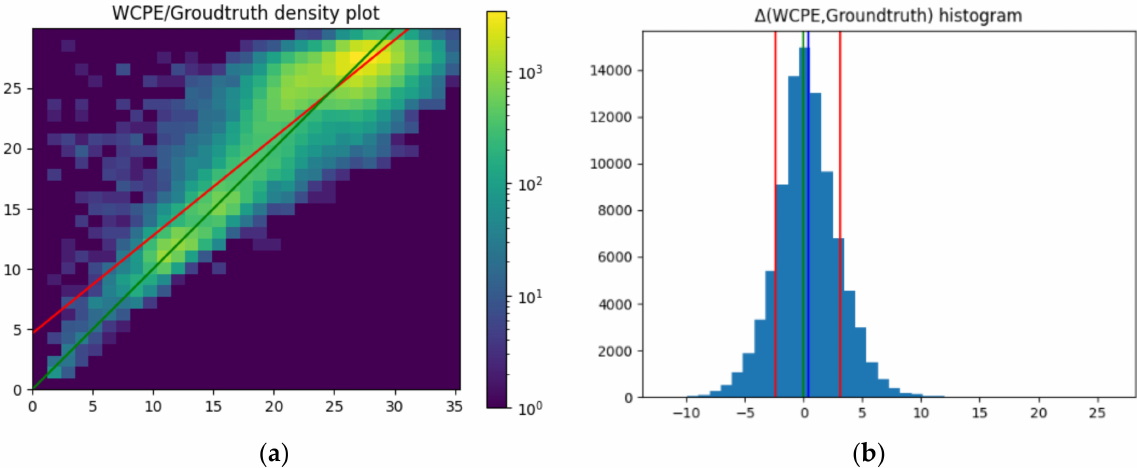
Figure 27. WCPE/Groundtruth scatter plot and Pleiades/WCPE histogram. ( a ) WCPE/Groundtruth scatter plot; ( b ) Pleiades/WCPE histogram.